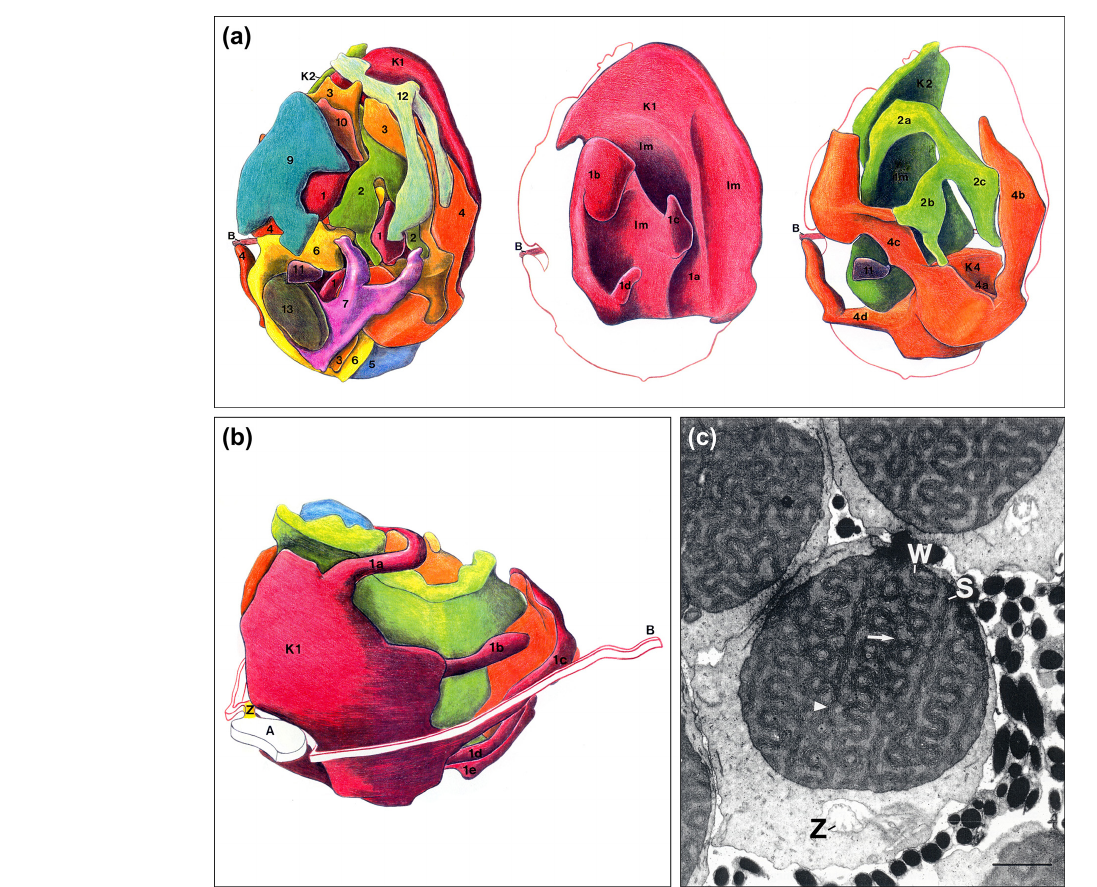
Figure 2. Morphogenesis of megamitochondria in retinal cone inner segments of Tupaia belangeri . (a) 3-D reconstructions, 12-day-old Tupaia: mitochondria (individually numbered and color-coded) are distributed in a basal (B)-to-apical size gradient. Megamitochondria (1, 2, and 4) exhibit voluminous apical bodies (K) and slender basal processes (a–d). Im, impressions from neighboring mitochondria. (b) 3- D reconstruction of apical megamitochondria which, in the cone inner segment of a 17-day-old Tupaia, are more subtly arranged in a basal-to-apical size gradient. Again, voluminous apical bodies (K1) and long-drawn-out basal processes (1a–1e) are discernible. A, cone outer segment; Z, cilium. (c) Transmission electron micrograph, 20-month-old Tupaia. Groups of four or five cristae pervade the apicalmost megamitochondrion either in a wavy (W) or in a straight (S) pattern. Note the switch of patterns within individual groups (arrowhead) and presumed junctions between adjacent groups (arrow). Scale bar = 1µm. Reproduced from Knabe (1995, Figs. 17, 18, 19, 26, 35). © the author